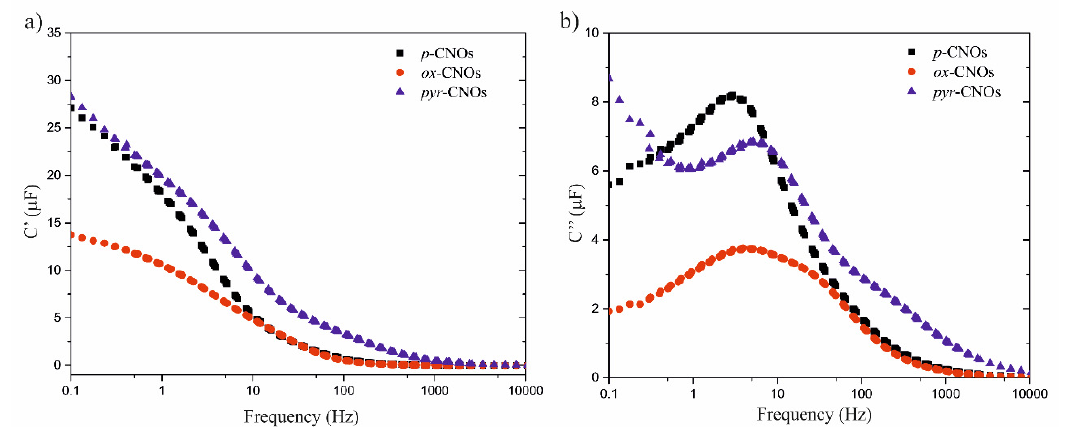
Figure 12. Dependence of the ( a ) real part of the capacitance and the ( b ) imaginary part of the capacitance on the frequency of the CNOs.